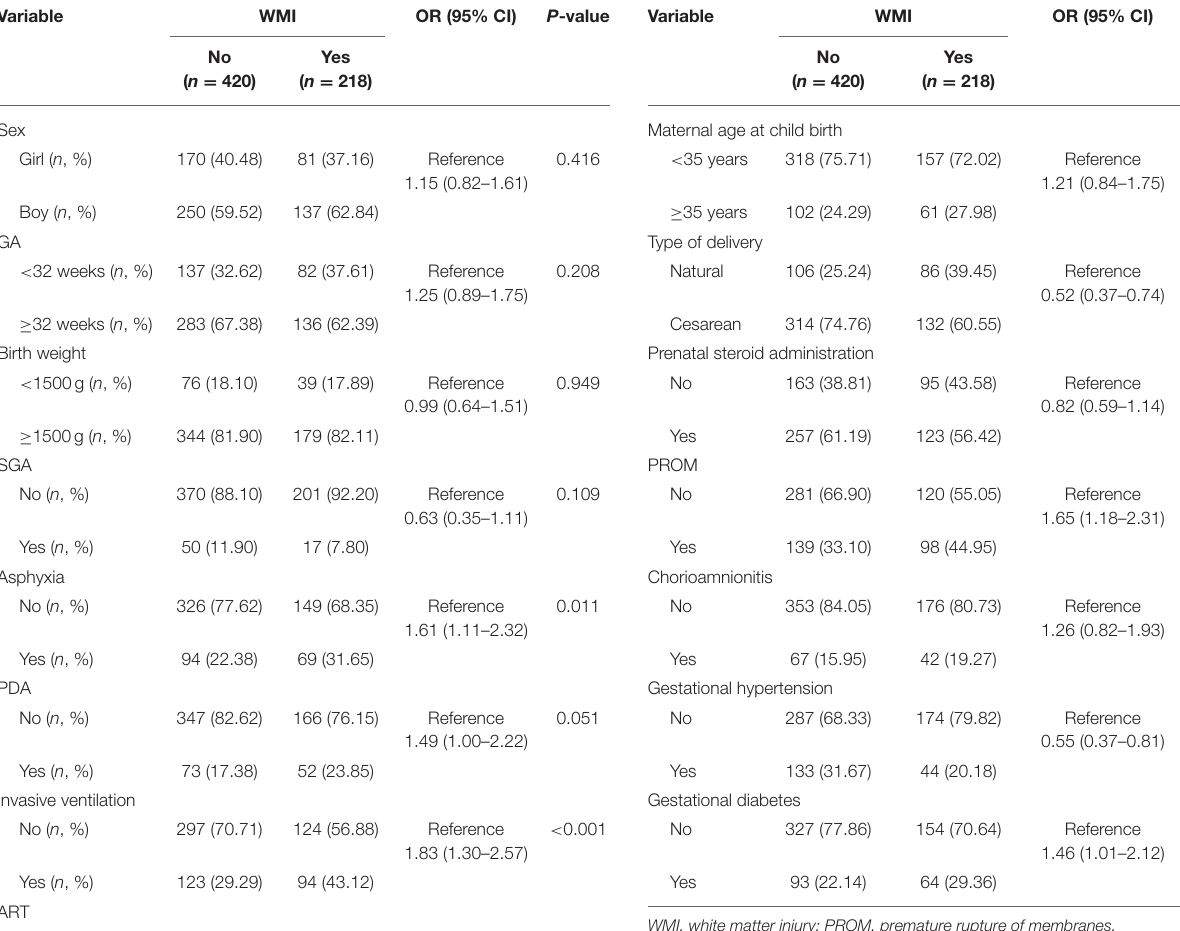
TABLE 2 | Univariate analyses of baseline of mothers in the case and control groups. Variable